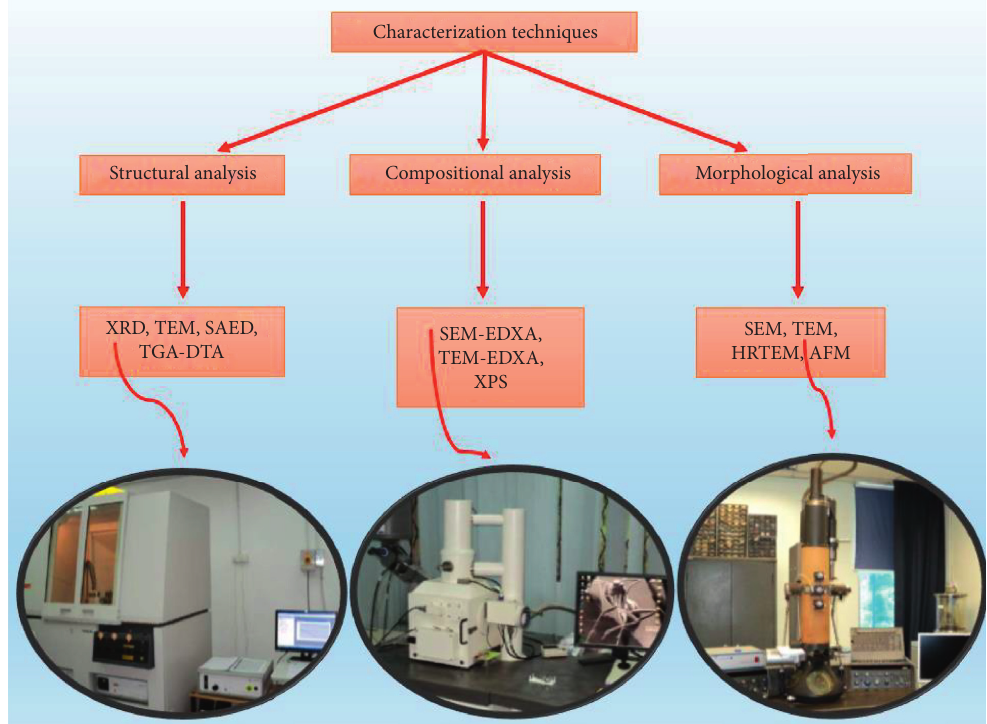
Figure 4: General techniques available for the characterization of